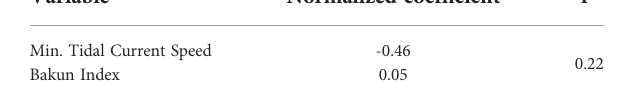
TABLE 2 Multiple linear regression analysis results for the dependence of the potential renewal strength on the minimum smoothed tidal current speed and the Bakun Index as observed through CTD casts in Saanich Inlet.